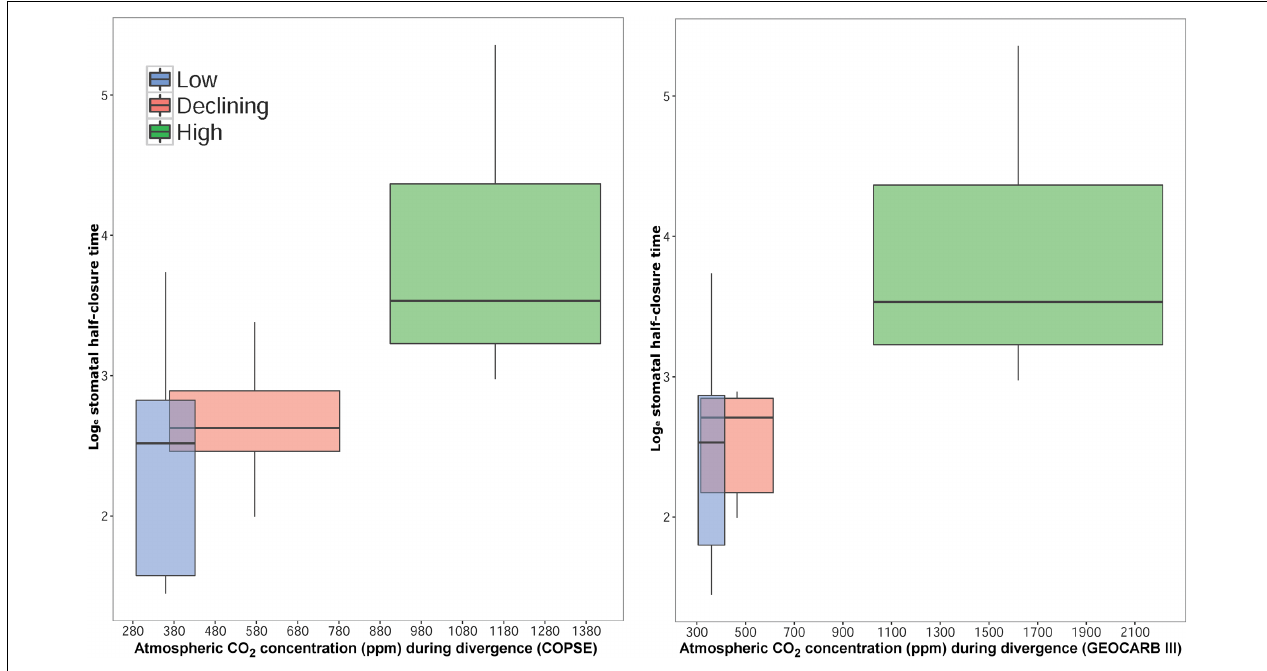
FIGURE 3 | log e (median stomatal half-closure time) of seven species, grouped by estimated atmospheric CO 2 concentration at time of taxa diversification into low, declining or high CO 2 groups. For COPSE model (Bergman et al., 2004), low CO 2 (280–439 ppm) includes Hordeum vulgare , Lepidozamia peroffskyana , and Solanum lycopersicon ; declining CO 2 (346–805 ppm) includes Podocarpus macrophyllus and Agathis australis ; high CO 2 (876–1443 ppm) includes Osmunda regalis and Ginkgo biloba (see Table 1 ). For GEOCARB III model (Berner and Kothavala, 2001), low CO 2 (300–420 ppm) includes Hordeum vulgare , Lepidozamia peroffskyana , Podocarpus macrophyllus , and Solanum lycopersicon ; declining CO 2 (300–630 ppm) includes Agathis australis ; high CO 2 (960–2280 ppm) includes Osmunda regalis and Ginkgo biloba (see Table 1